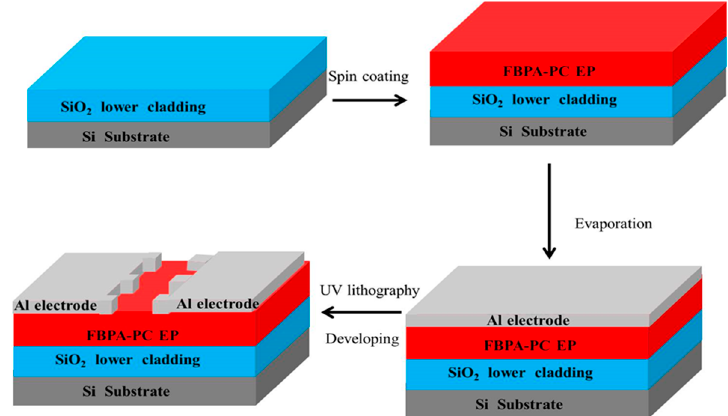
Figure 10. Fabrication process for the proposed apodized sampled grating.